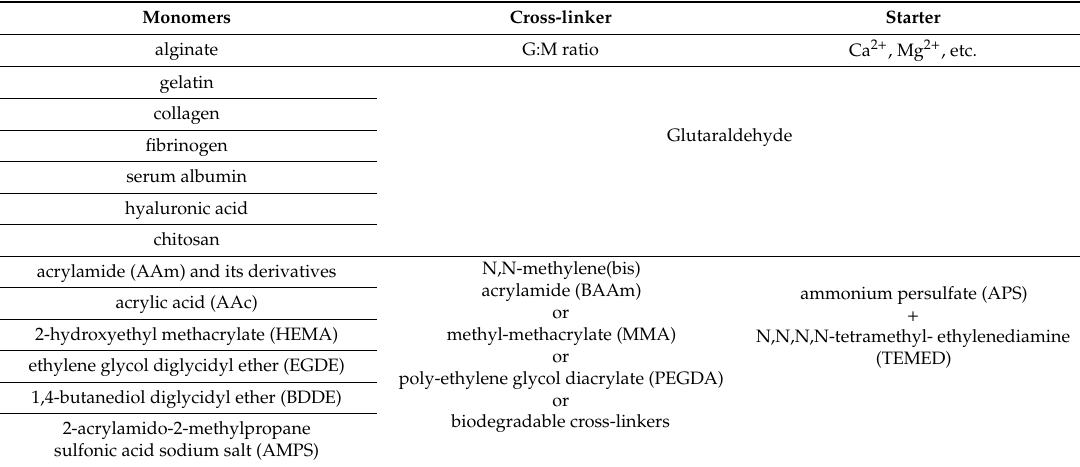
Table 1. Common raw materials for cryogel production. Information obtained from [11]. The abbreviations were listed in Section